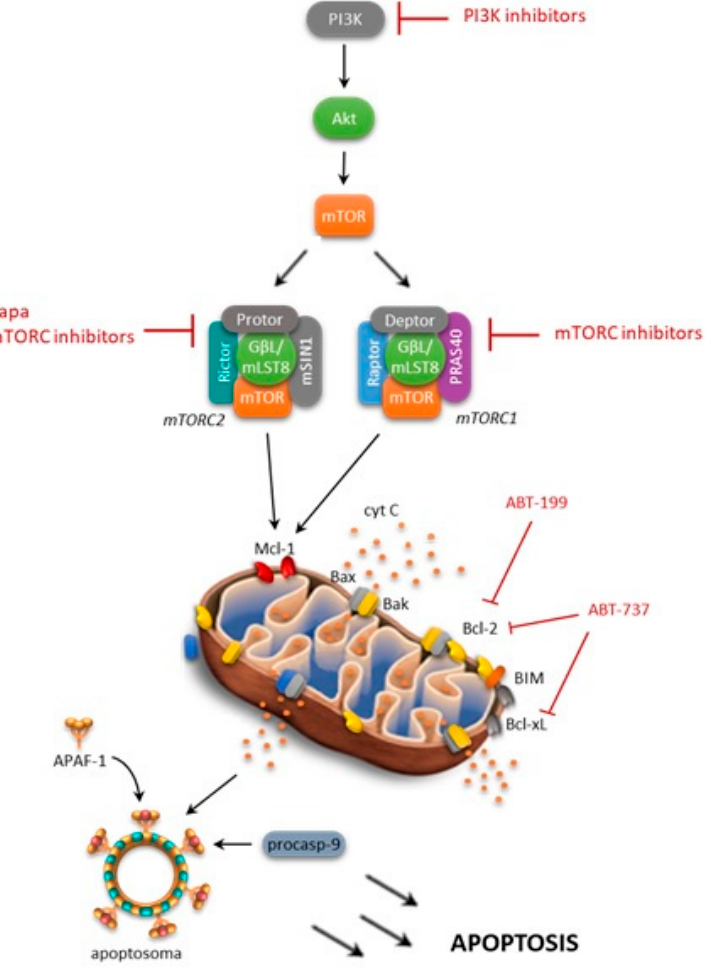
Figure 3. mTOR and Bcl-2 family member interactions. Arrows: positive interaction; T-bars: inhibition.